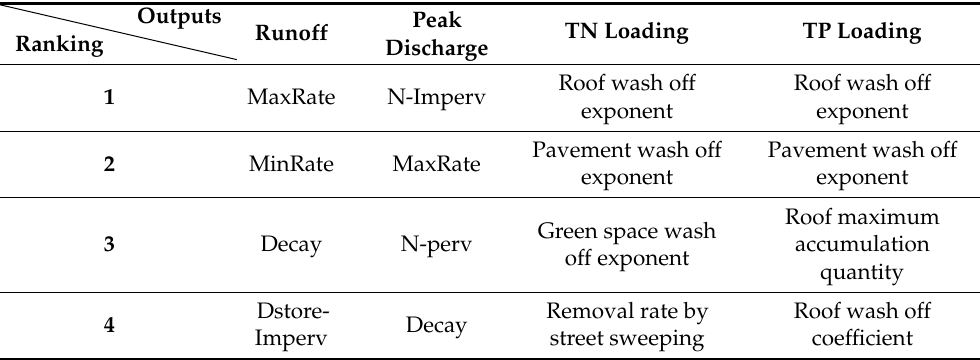
Table 3. Sensitivity ranking of parameters in